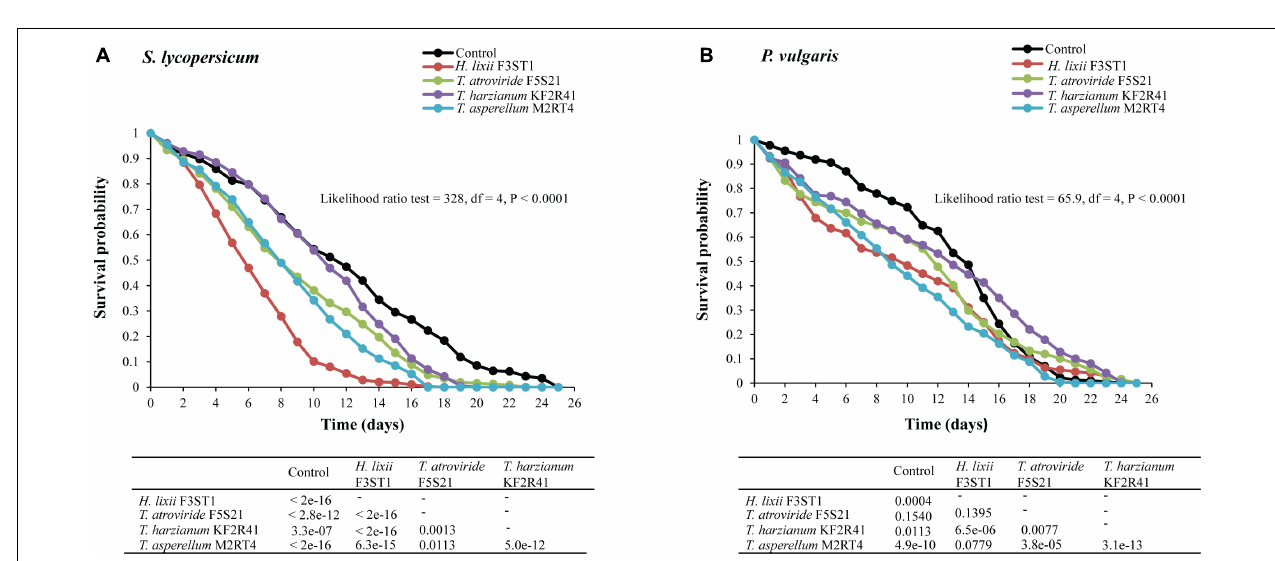
FIGURE 5 | Survival curves of T. vaporariorum first generation (F1) progeny after emergence from endophytically colonised S. lycopersicum (A) and P. vulgaris (B) plants by different fungal isolates of H. lixii F3ST1, T. asperellum M2RT4, T. atroviride F5S21, and T. harzianum KF2R41.